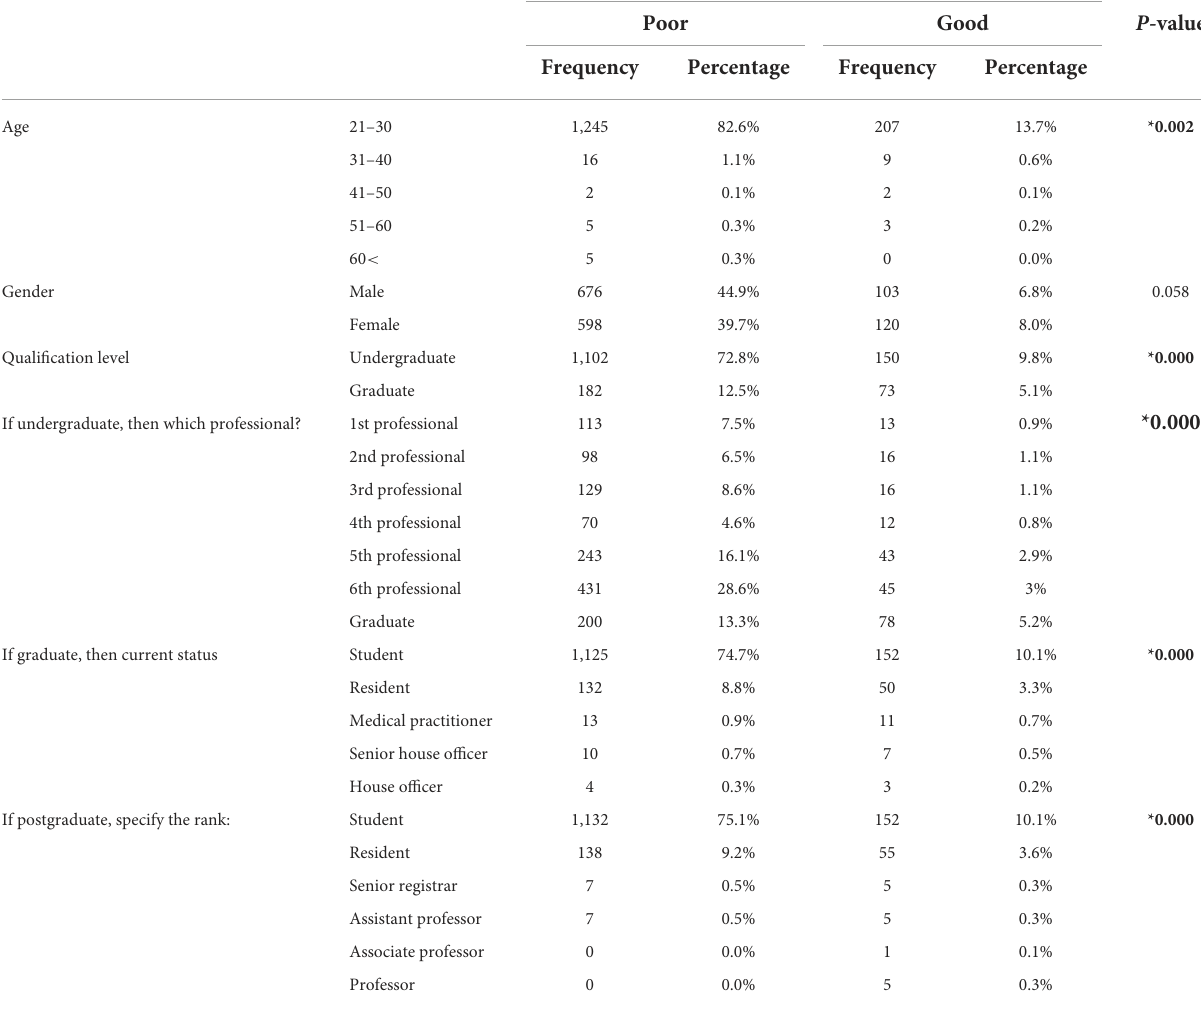
TABLE 10 Practice of AI based on gender, age, qualification level, professional, current status and rank of the